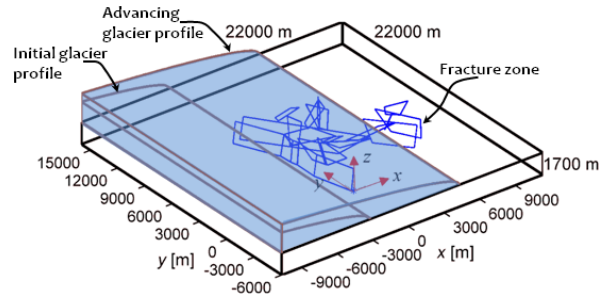
Figure 1. Geometry of the fractured rock mass subjected to loading by the advancing